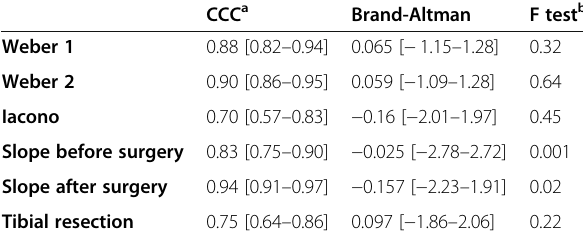
Table 2 The assessment of concordance is summarized. The 95% confidence interval is shown in square